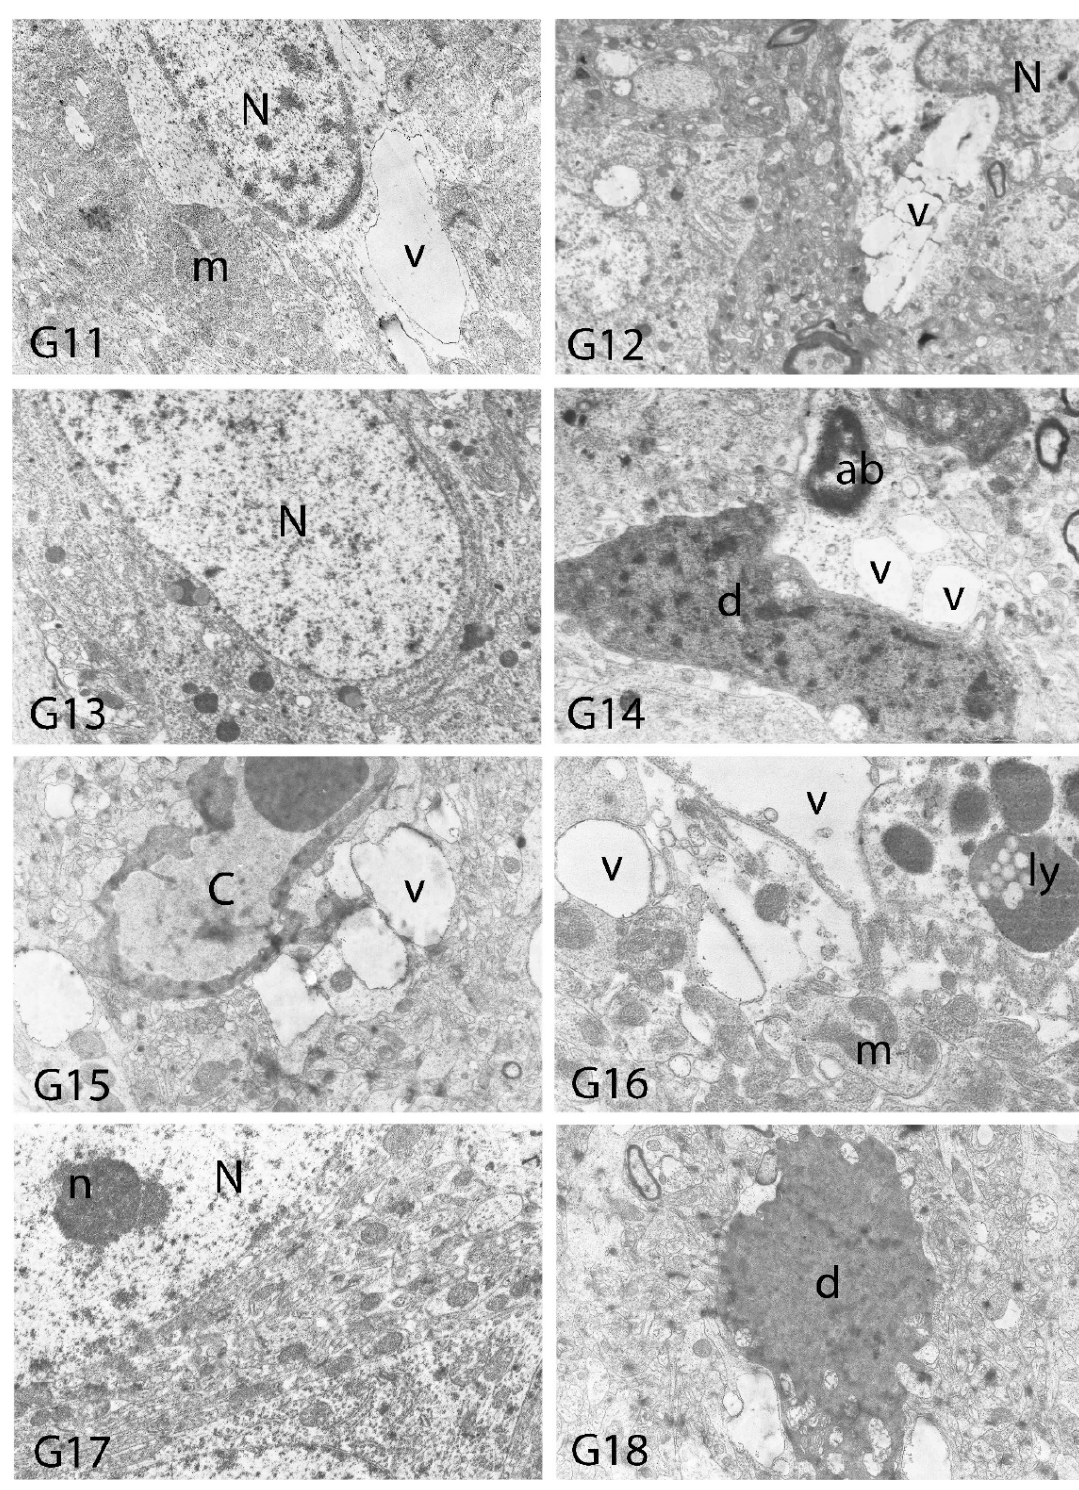
Figure 13. Electron micrographs of rat cerebral cortices from Groups 11 to 18 (G11–G18). N, nucleus; n, nucleolus; C, capillary; ab, apoptotic body m, mitochondria; v, vacuolar degeneration; ly, secondary lysosomes; d, neuronal debris. Group definitions are as in Figure 9.